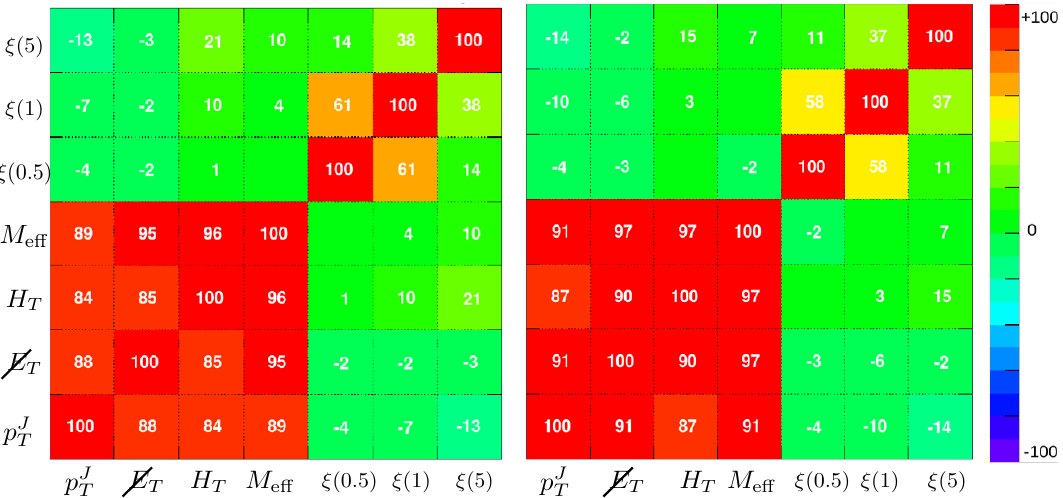
Figure 5 . Correlation between the variables for MSSM (left) and MUED (right). Clearly the (cid:24) variables are uncorrelated with the conventional variables which when taken into account should result in excellent S=B as well as S= p S + B improvements.